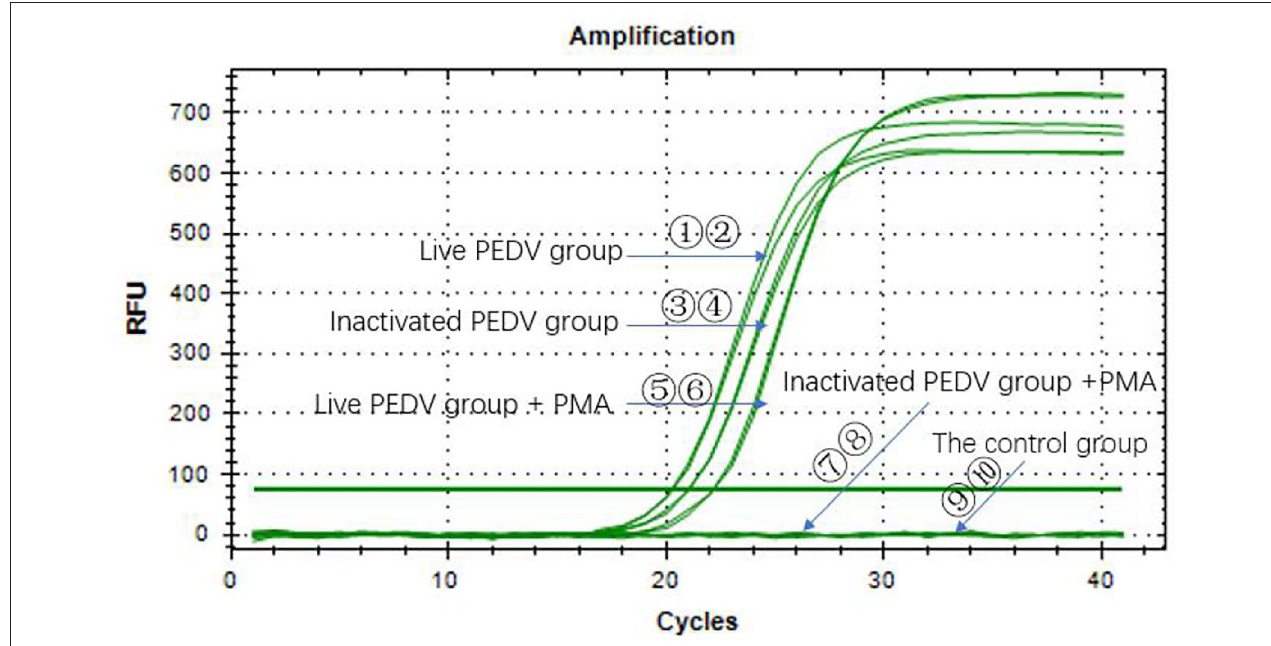
FIGURE 5 | PMA RT-qPCR on infectious and heat-inactivated